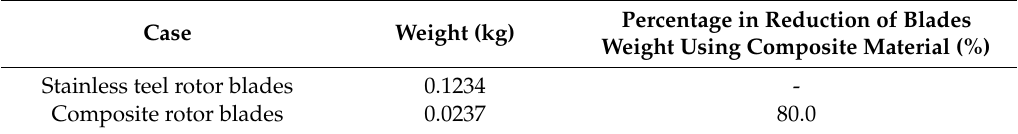
Table 5. Rotor blades weight.